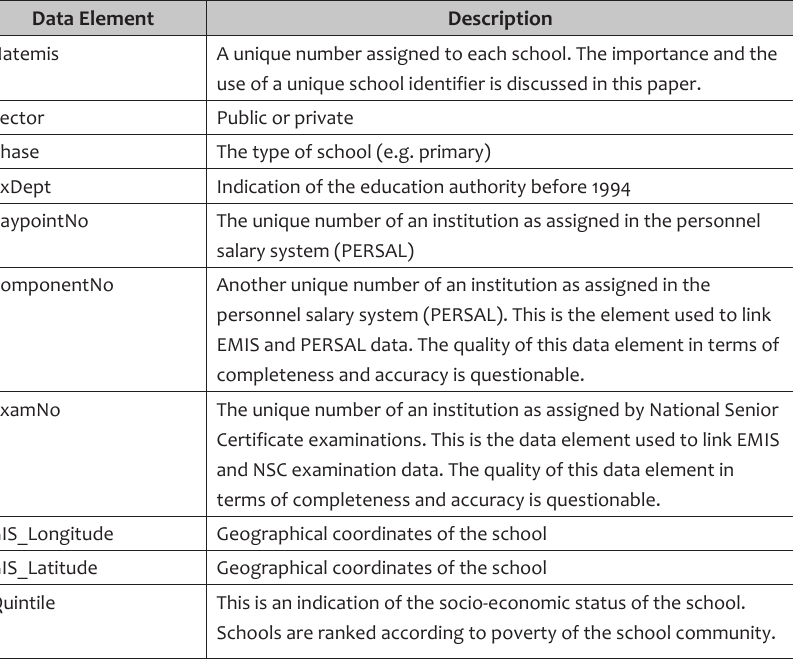
Figure 1 indicates the distribution of schools according to quintiles 1 and shows the descriptive statistics possible from the master list of schools. Note that schools quintiles are often used in multivariate analyses as control measures for school performance. South African schools are divided into five categories (quintiles) based on the socio-economic status of the community in which the school is situated. Quintile 1 schools are the poorest, while quintile 5 schools are the least